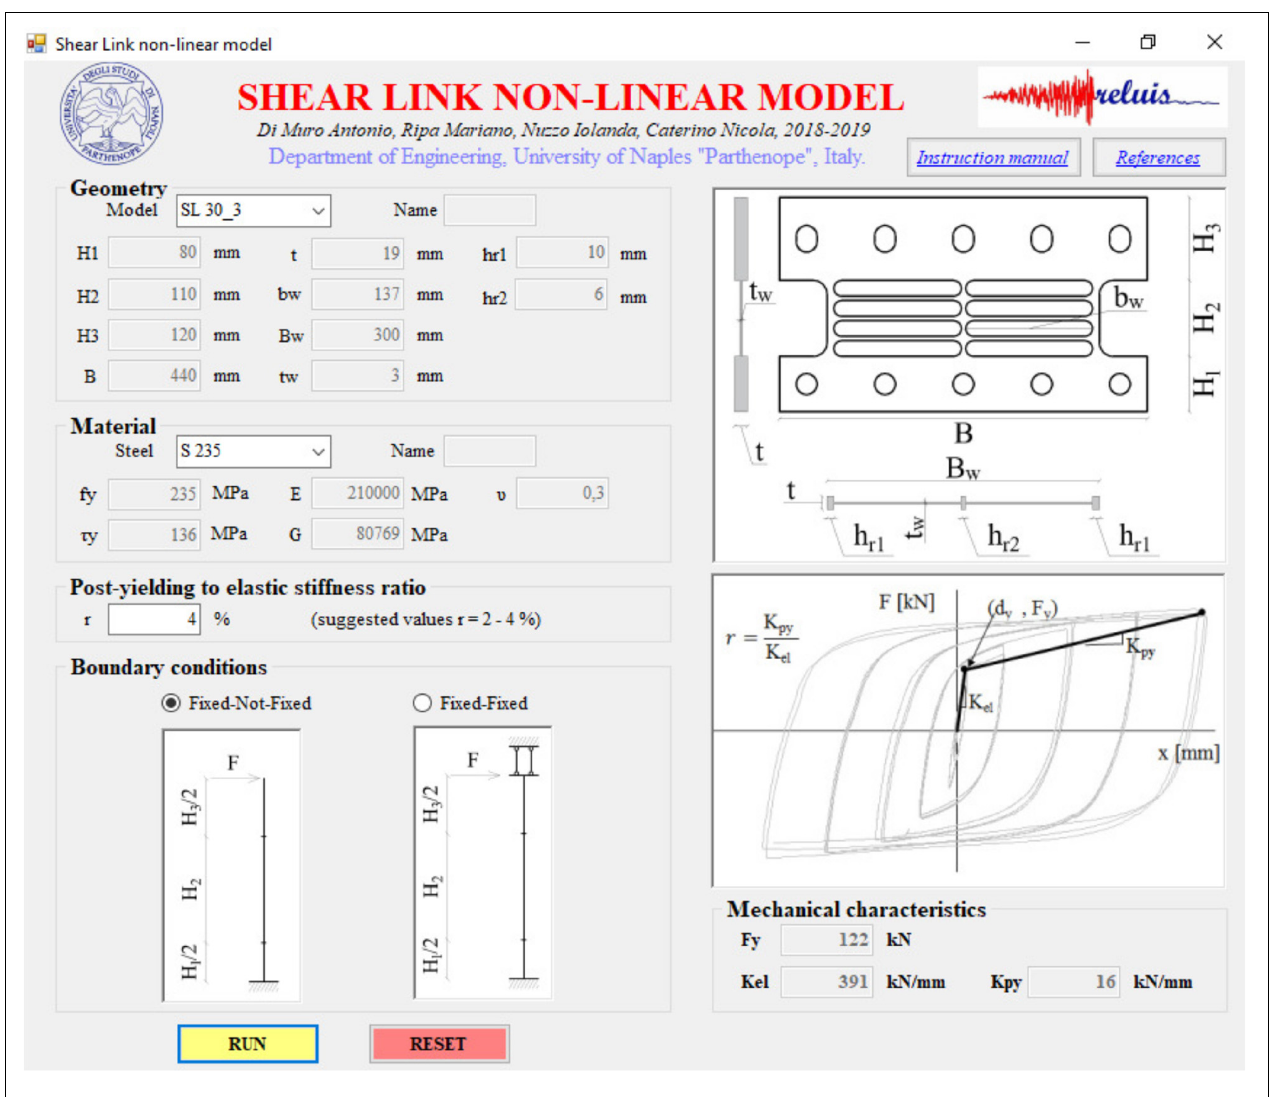
FIGURE 6 | Screenshot of the Visual Basic tool to calibrate SL mechanical